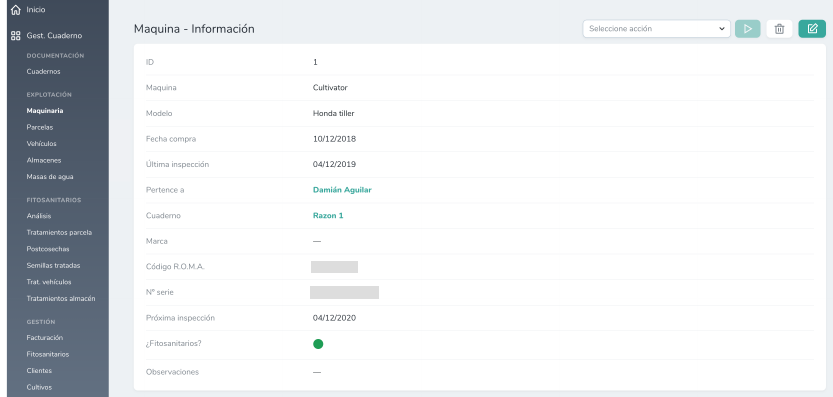
Figure 17. Machinery management detail. Personal data has been removed from the